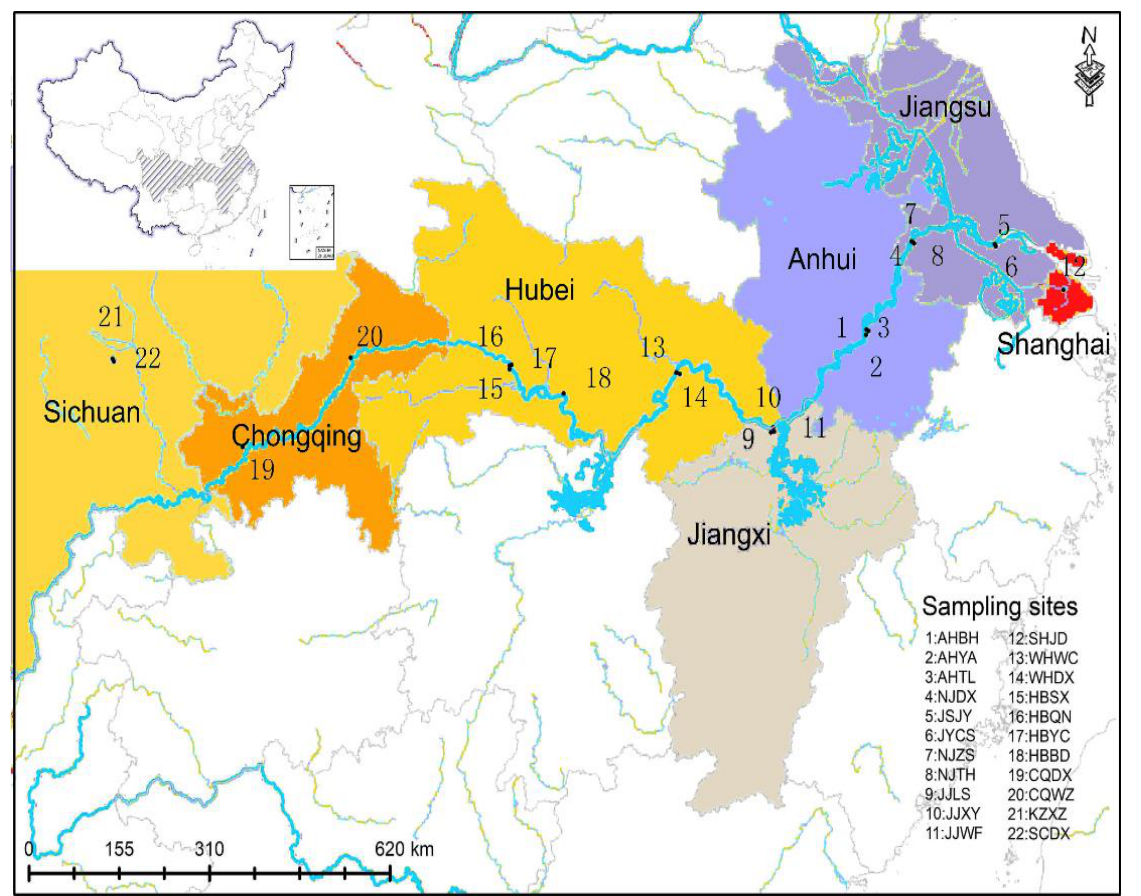
Figure 1. Ae. albopictus individuals were collected between July and September 2018 at 22 cities along the Yangtze River Basin. Table 1. Sampling information of all 22 Ae. albopictus populations distributed in various regions of the Yangtze River.